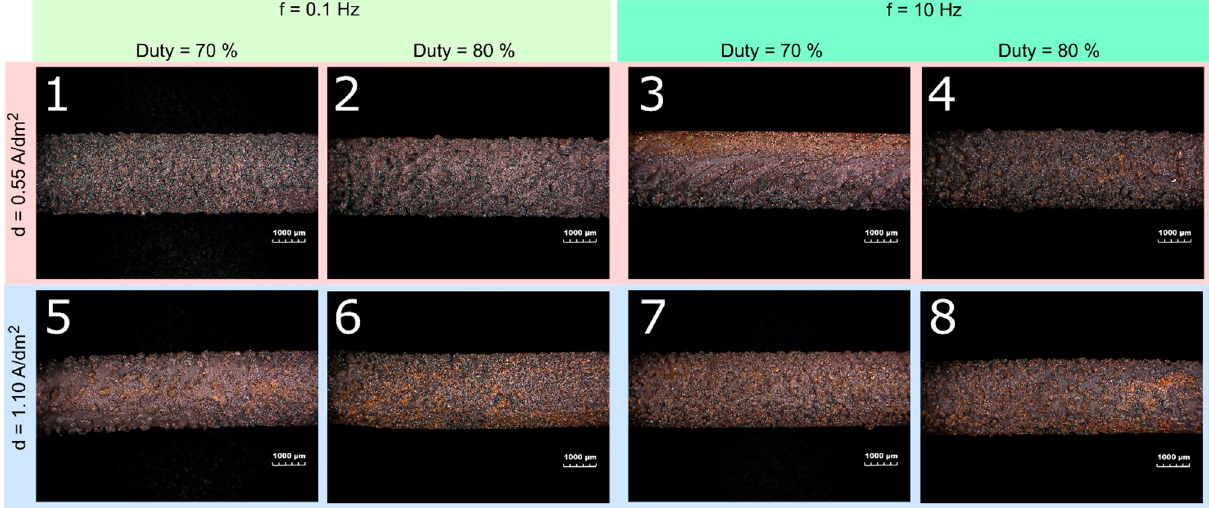
Figure 3. Morphology of the Cu-GnP composite coatings: the number in white represents the test scenario (see Table 6).